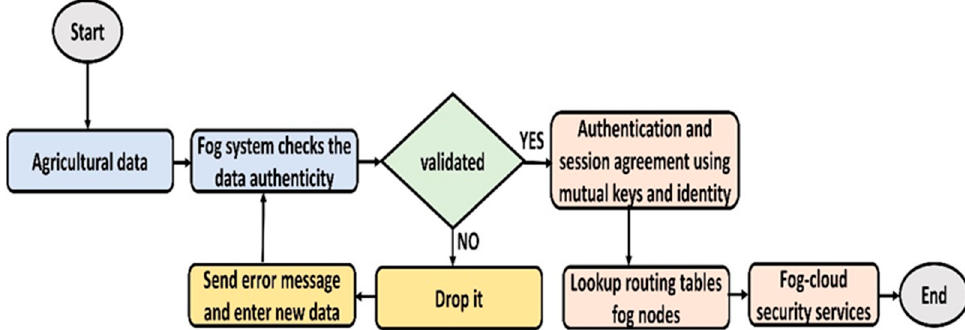
Figure 4. Flowchart of the proposed security algorithm.